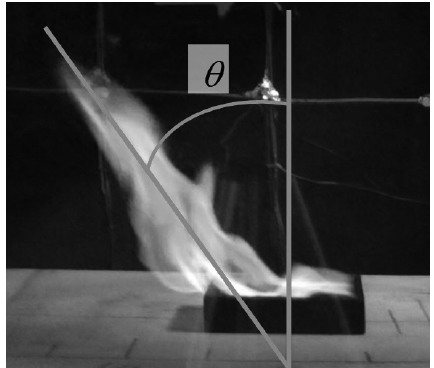
Fig. 5. Schematic of flame tilt angle